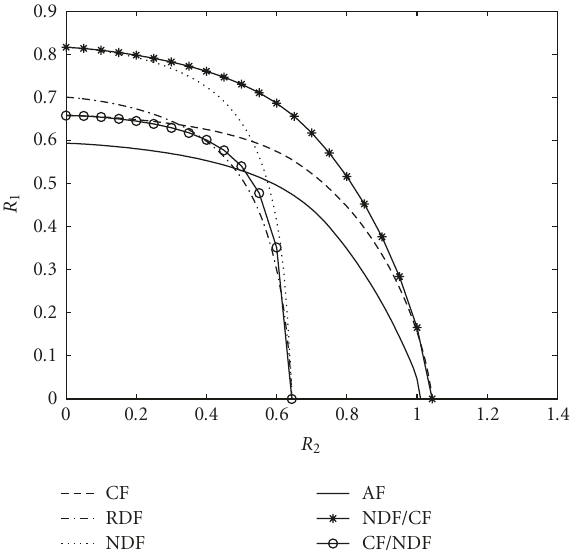
Figure 12: Comparison between the achievable rate regions when using the same relaying strategy for both users and when using di ff erent relaying strategies, for Scenario 1.